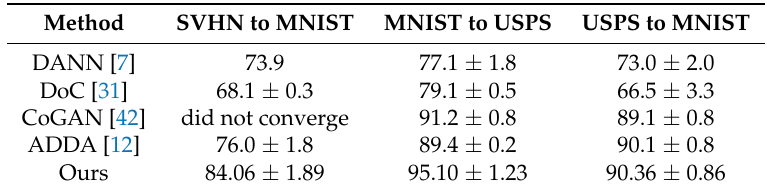
Table 1. Experimental results on unsupervised adaptation among 3 centered digits datasets.